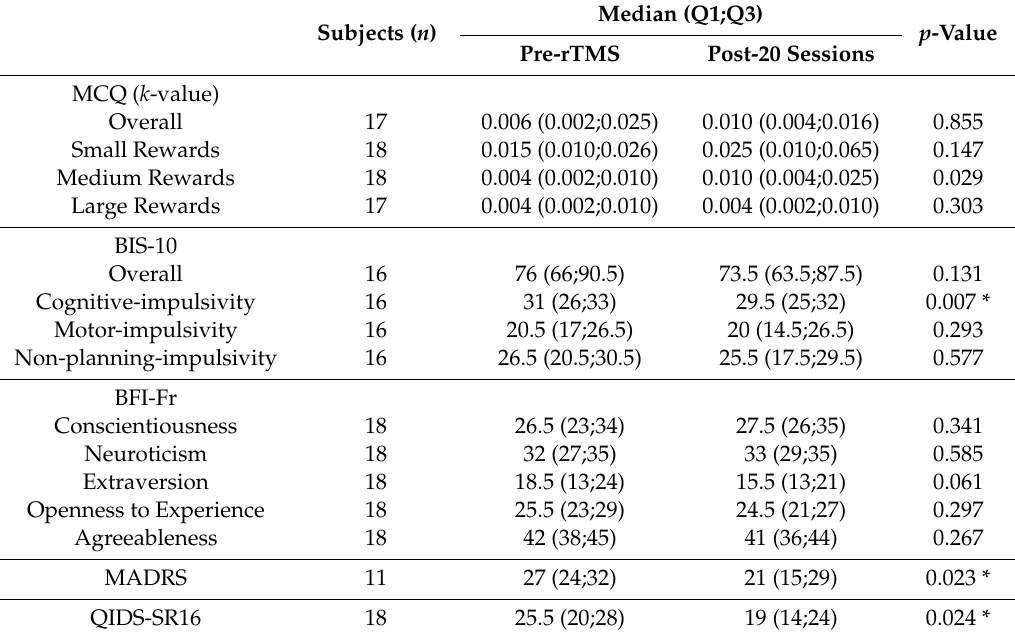
Table 2. Median values and quartiles (Q1;Q3) for pre-post 20 rTMS sessions measures with p